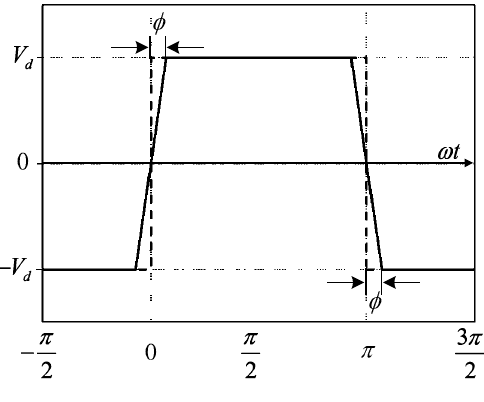
Figure 10. Proposed TCV implementation strategy; ( a ) triangle waveform function ( ) g t with peak k ; ( b ) TCV shapes comparison. sinusoidal waveform function